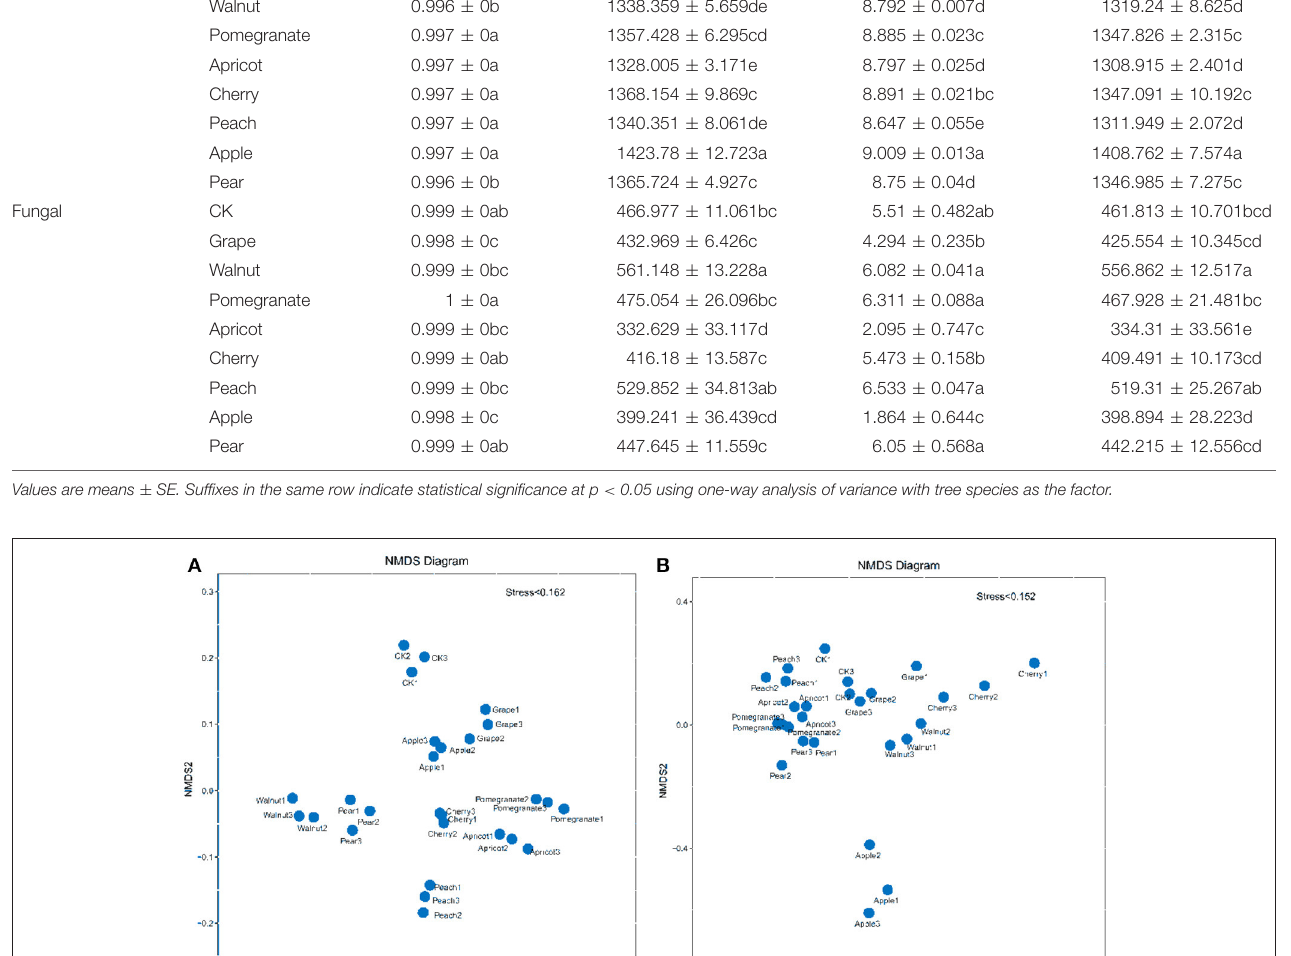
1,148 total OTUs obtained ( Figure 4C ). Similar to the bacterial communities, each species of deciduous fruit tree had its own unique fungal taxa. The number of unique fungal taxa was greater in the control and pear soils compared to the other soil samples, corresponding to 4.18 and 3.57% of the OTUs detected, respectively. In addition, 25, 19, 13, and 11 OTUs (2.18, 1.66, 1.13, and 0.96%) were only detected in the pomegranate, grape, apricot and peach rhizospheres, respectively. The Venn